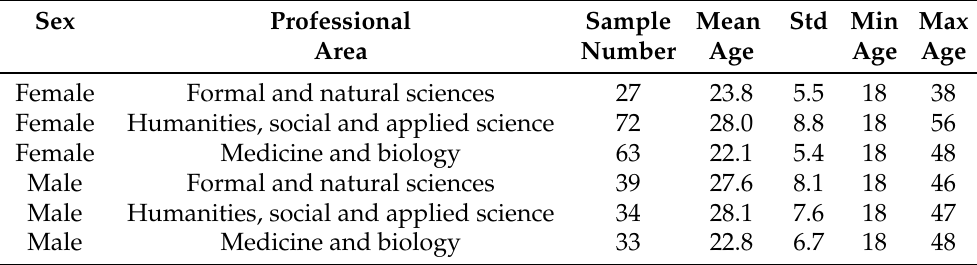
Table 2. Subjects, grouped by age, education, sex, and professional area of current work.